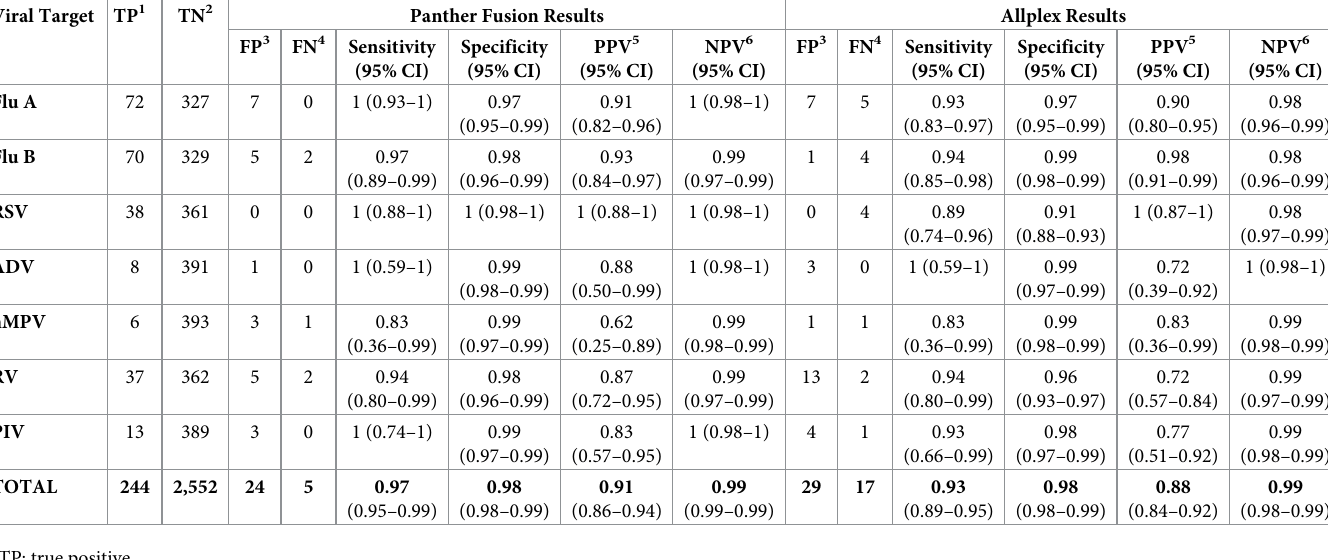
Table 4. Comparison of Panther Fusion and Allplex for detection of viruses in patient samples collected from December 2017 to January 2018. Viral Target TP